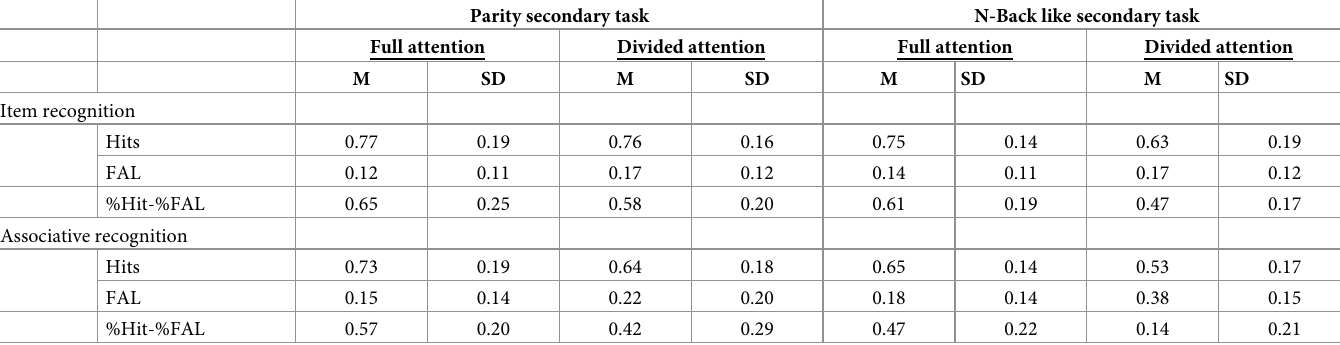
Table 1. Memory performance; proportion of hits and false alarms (FAL) in full- and divided-attention conditions for the two experimental